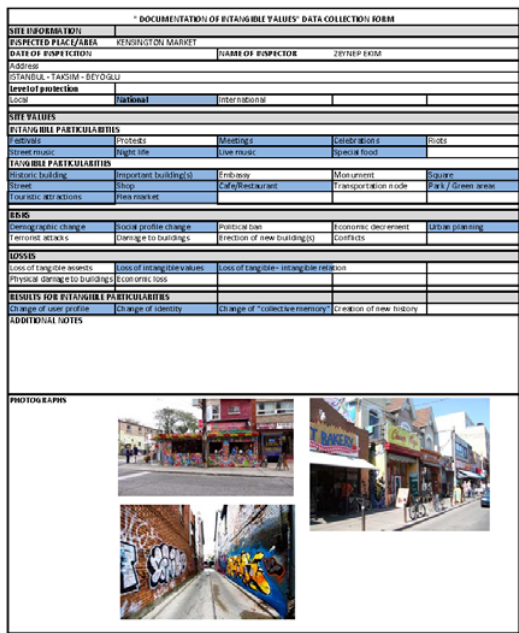
Figure 11: Collected data of Kensington